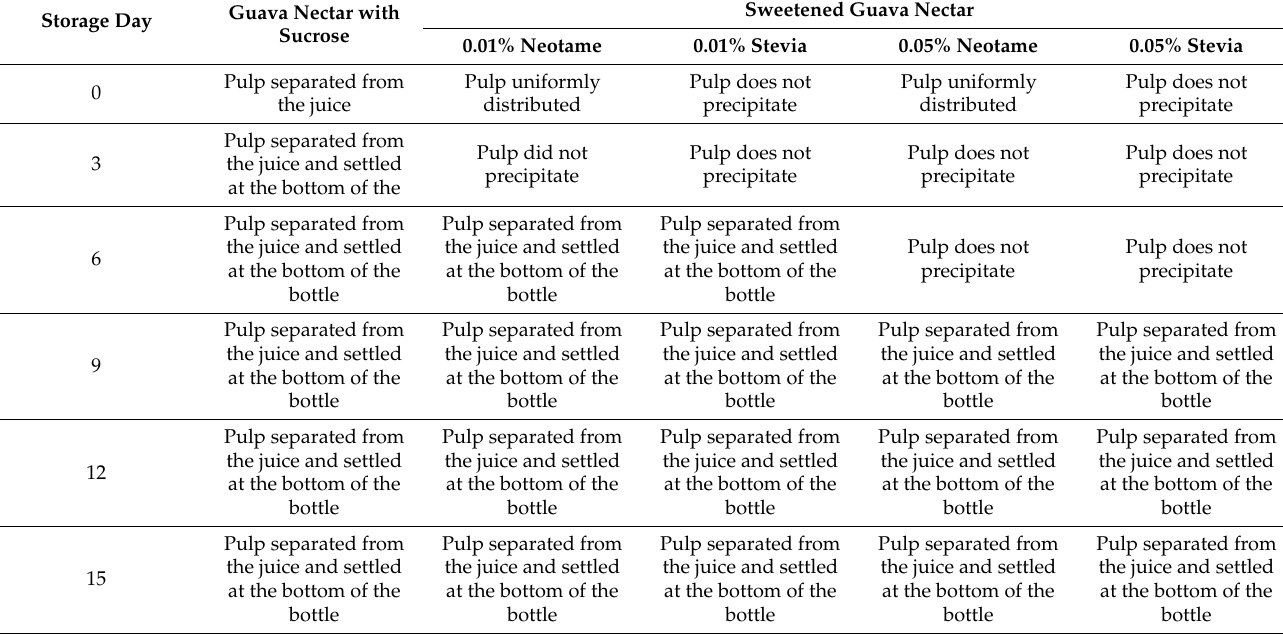
Table 2. The appearance of guava nectar and sweetened guava nectar during 15th of storage day at 5 ◦ C.